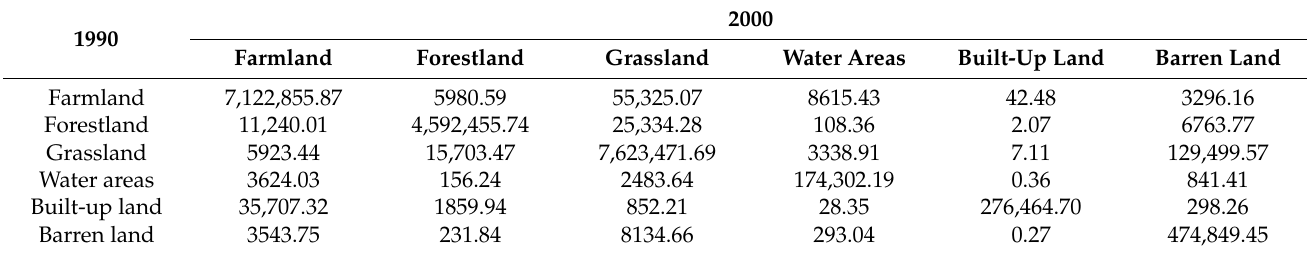
Figure 3. Spatial distribution of land-use in Shaanxi Province from 1990 to 2020. Table 3. Land-use transfer matrix of Shaanxi Province from 1990 to